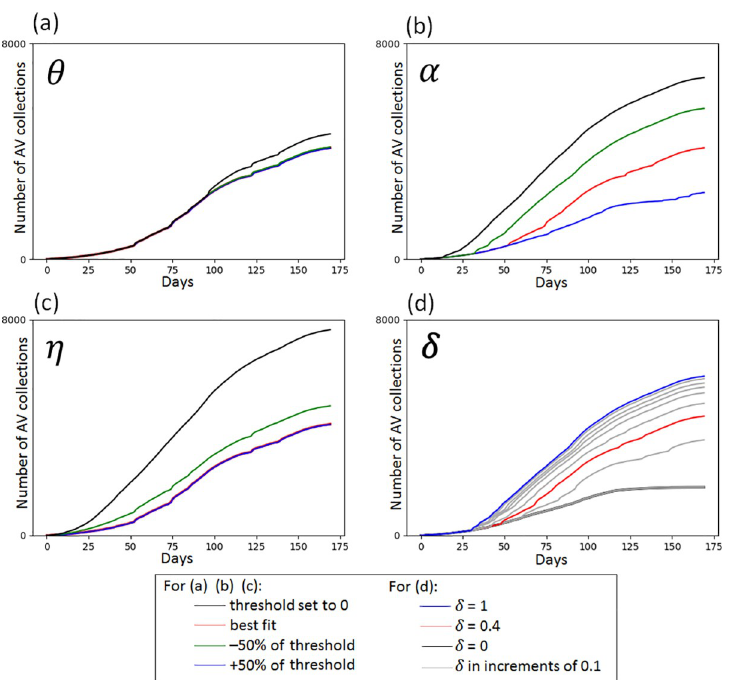
Fig 3. Sensitivity analyses: Impact of varying α , η , θ and δ on AV